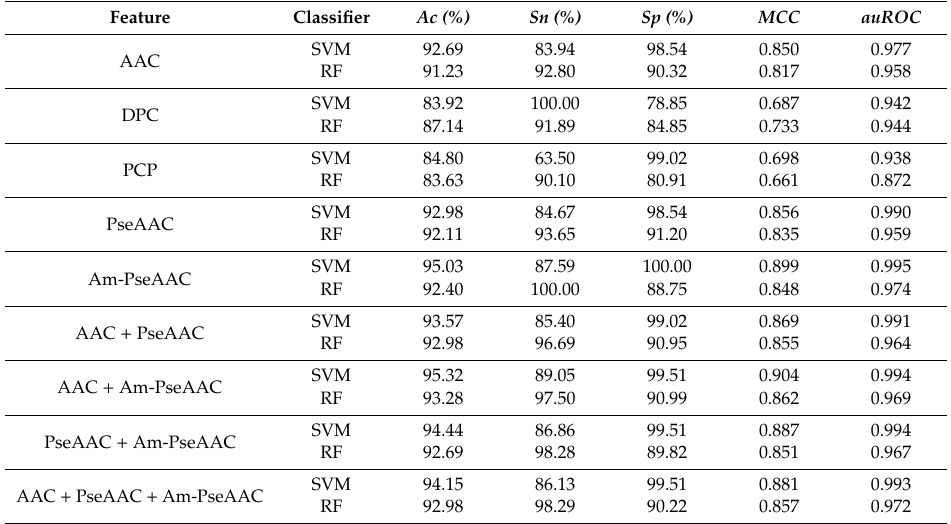
Table 2. Performance comparison of SVM and RF with various types of sequence features over five-fold cross-validation.